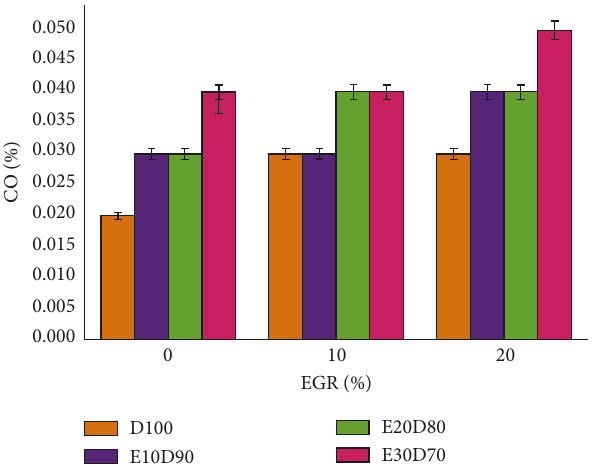
Figure 12: Variation in HC with EGR (0%, 10%, and 20%) at 60%